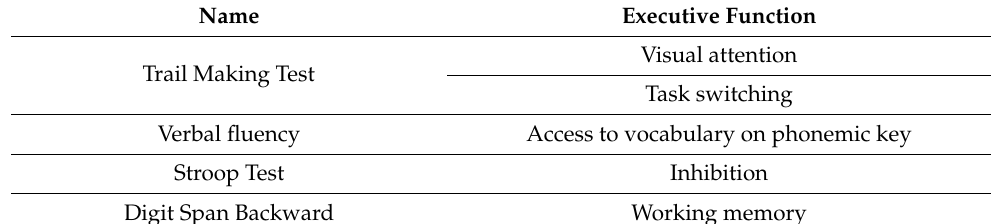
Table 1. Pretask evaluation: list of traditional neuropsychological tests for the assessment of EFs.